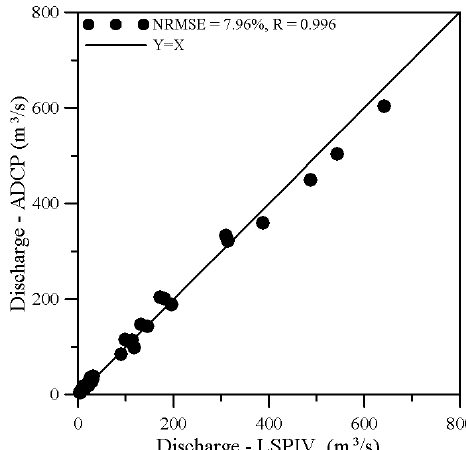
Figure 12. Comparison of estimated river discharge from the ADIS/LSPIV and ADCP measurements.